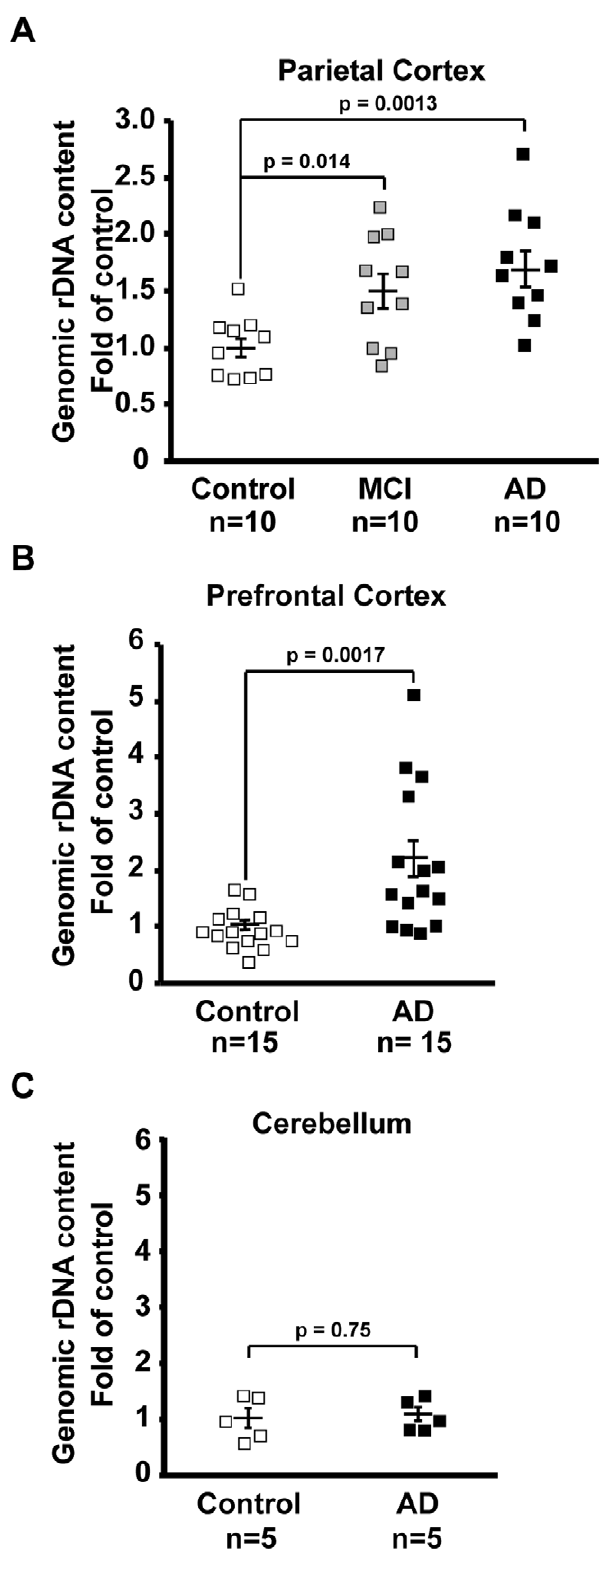
Figure 5. Increased genomic rDNA content in cerebro-cortical samples from MCI- and AD individuals. Genomic rDNA was quantified by qRT-PCR; for normalization, tRNA-K-CTT gene was selected as its unclustered copies are scattered throughout several human chromosomes providing a good control of the non-rDNA